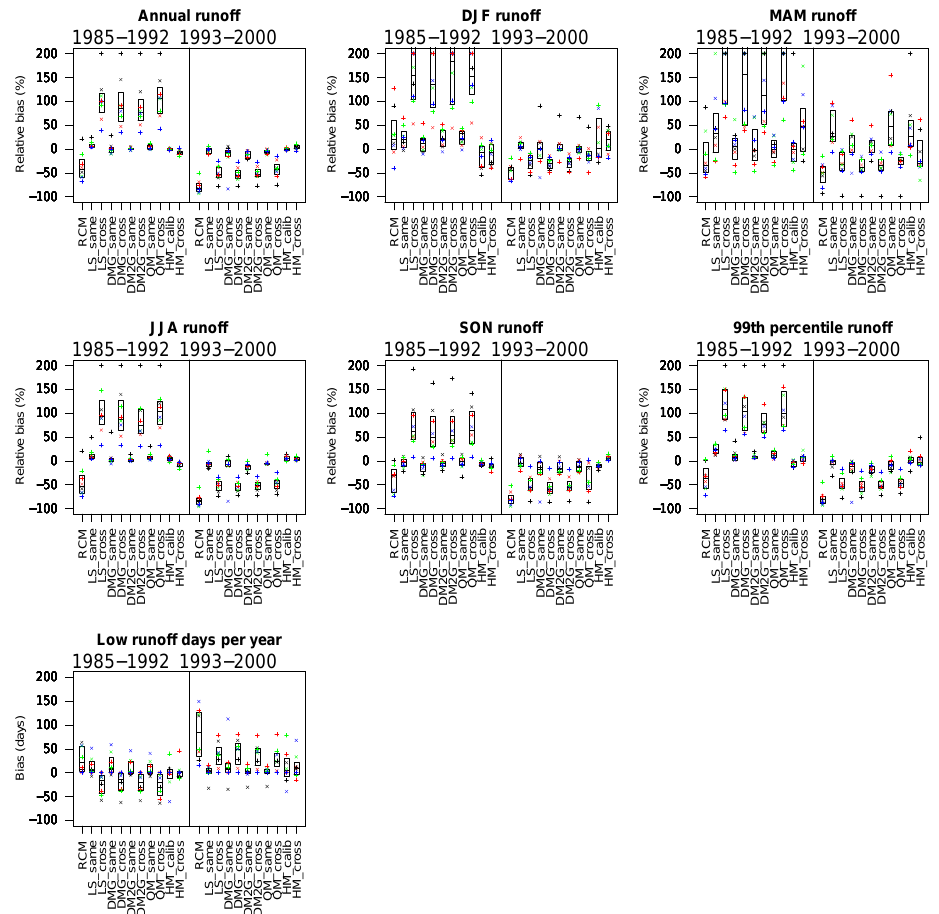
Figure 5. As for Fig. 4, but using results from hydrological model